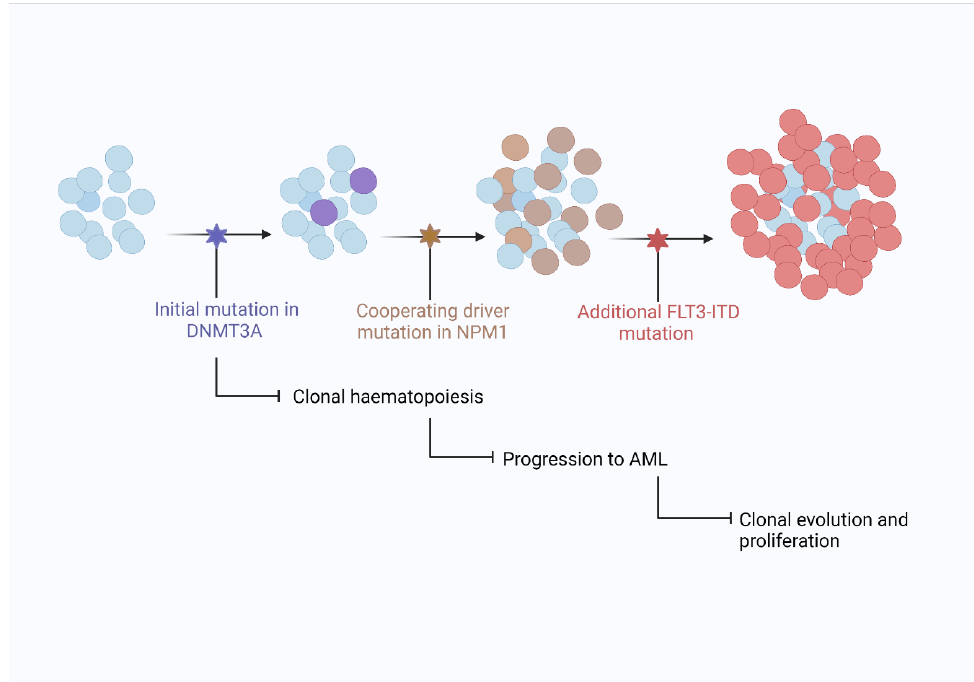
Figure 3. Model showing progression of clonal haematopoiesis to AML. Clonal haematopoiesis is believed to exist prior to AML development with mutations in DNMT3A often present. The acquisition of an NPM1 mutation is considered a driver mutation resulting in transformation to AML with further mutations in FLT3-ITD driving proliferation and establishing a predominant clone [20].